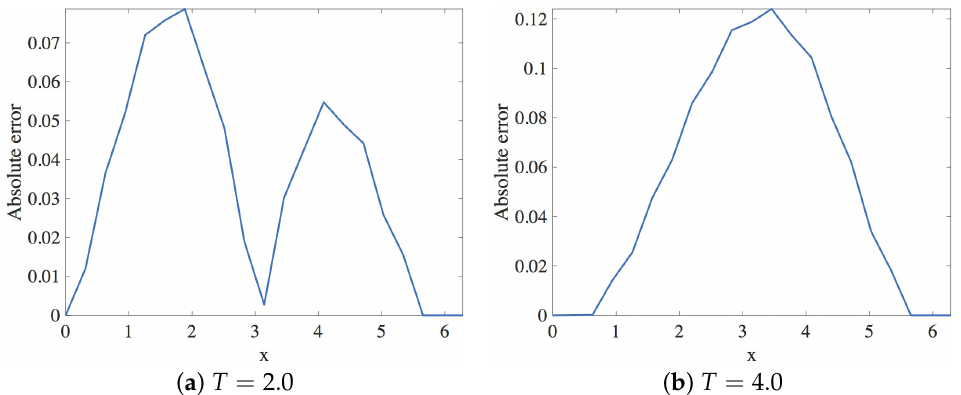
Figure 13. Plot of the solution profile of Numerical Experiment 1 by Scheme 3. The spatial and temporal step sizes are h = π /10 and k = 0.001, respectively.